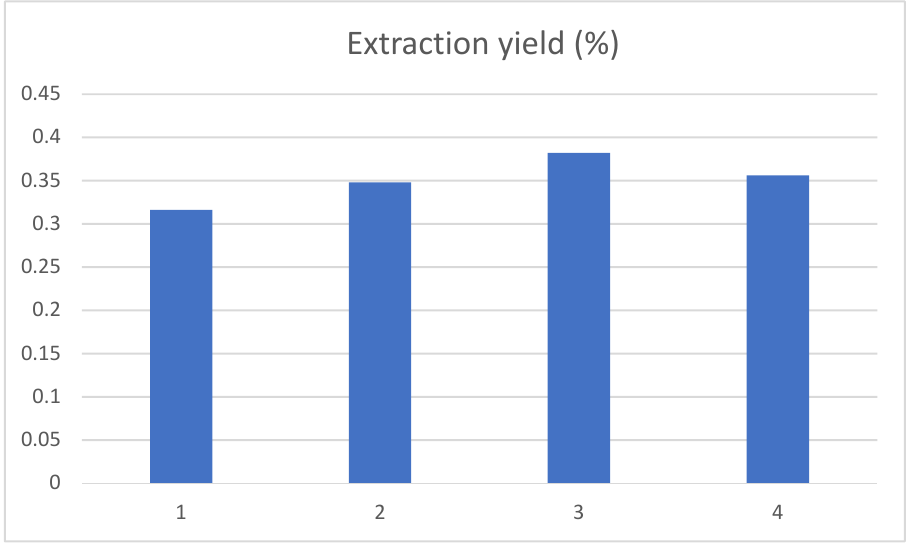
Figure 4. Influence of ultrasonic temperature on the extraction yield of chlorogenic acid, and the 1, 2, 3, and 4 represent the ultrasonic extraction temperature of 50 °C, 60 °C, 70 °C and 80 °C, respec- tively.